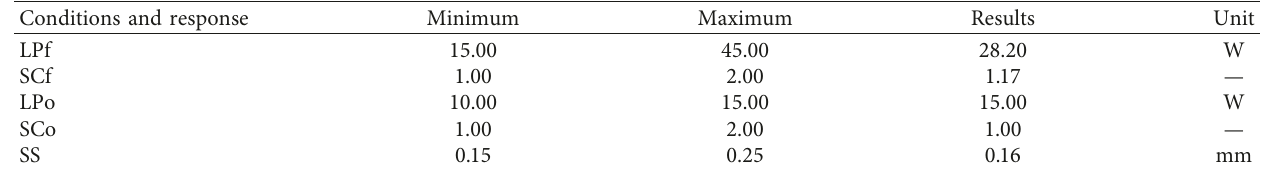
Table 6: Proposed optimization criterion with